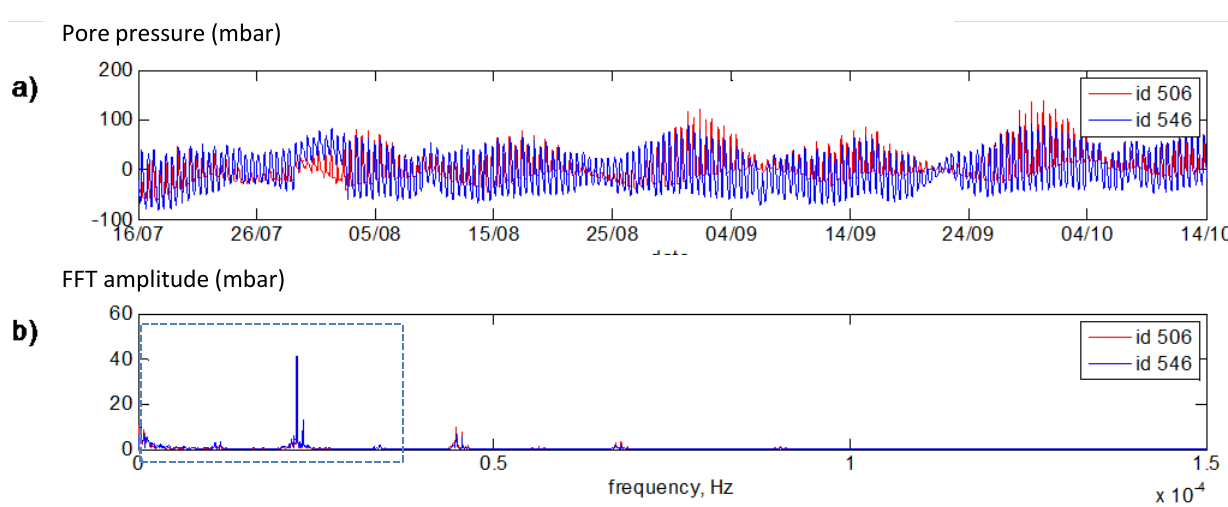
Figure 22. ( a ) Pore pressure data #506 (red line) and #546 (blue line) measurements after normalization (mean value was subtracted). ( b ) FFT spectra of #506 (red line) and #546 (blue